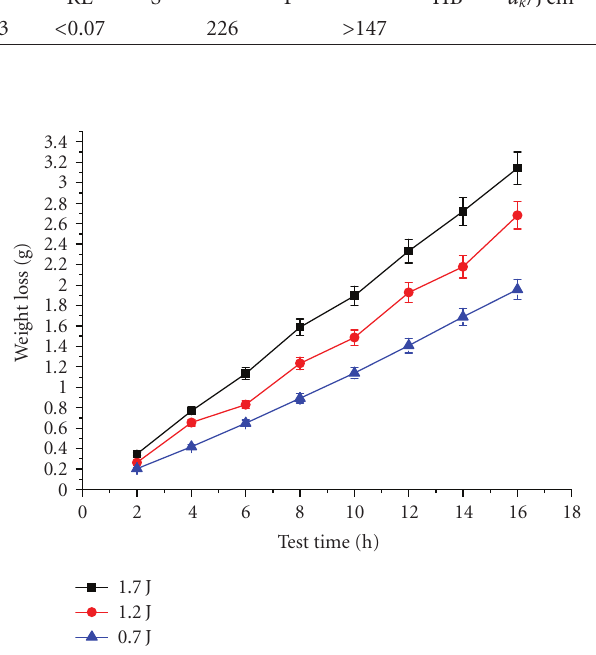
Figure 1: Schematic diagram of the impact corrosion-abrasion tester.